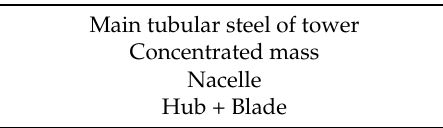
Table 2. Mass of tower components (kg).